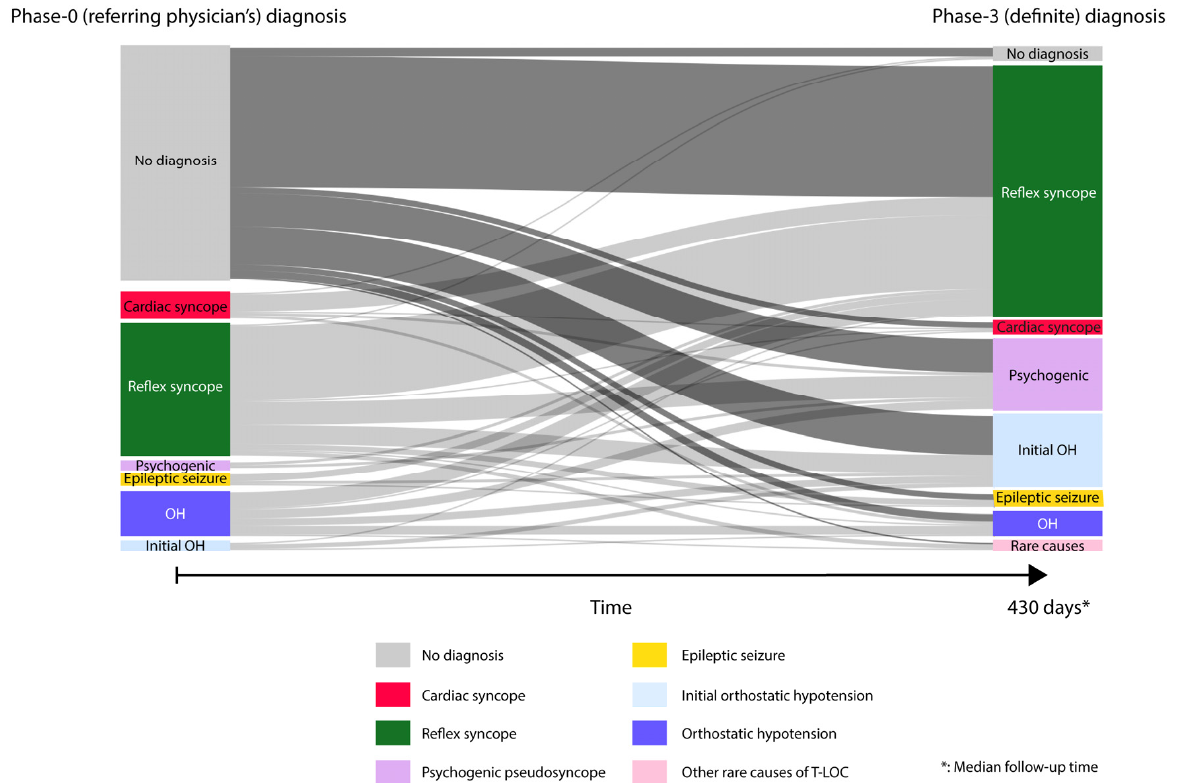
Figure 1. Changes in diagnoses between phase 0 (referral diagnosis) and phase 3 (reference diagnosis by critical follow-up with expert commi tt ee). Transition plot (or Sankey diagram) depicting the fl ow of patients with a diagnosis in phase 0 to phase 3. Coloured bars show diagnostic groups in phase 0 (left) and phase 3 (right). The size of the bars re fl ects the number of patients in each group. The light grey bar depicts patient fl ow from phase 0 to phase 3. The darker grey fl ow from left to right highlights the fl ow of patients without a phase 0 diagnosis. Flow size re fl ects the number of patients that correspond to the fl ow.